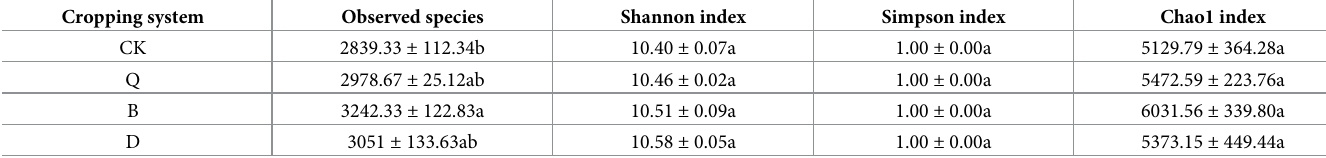
CK: Continuous tomato cropping; Q: Celery/tomato rotation; B: Cabbage/tomato rotation; D: Kidney bean/tomato rotation. Different lowercase letters in a row indicate that the differences are statistically significant (P <